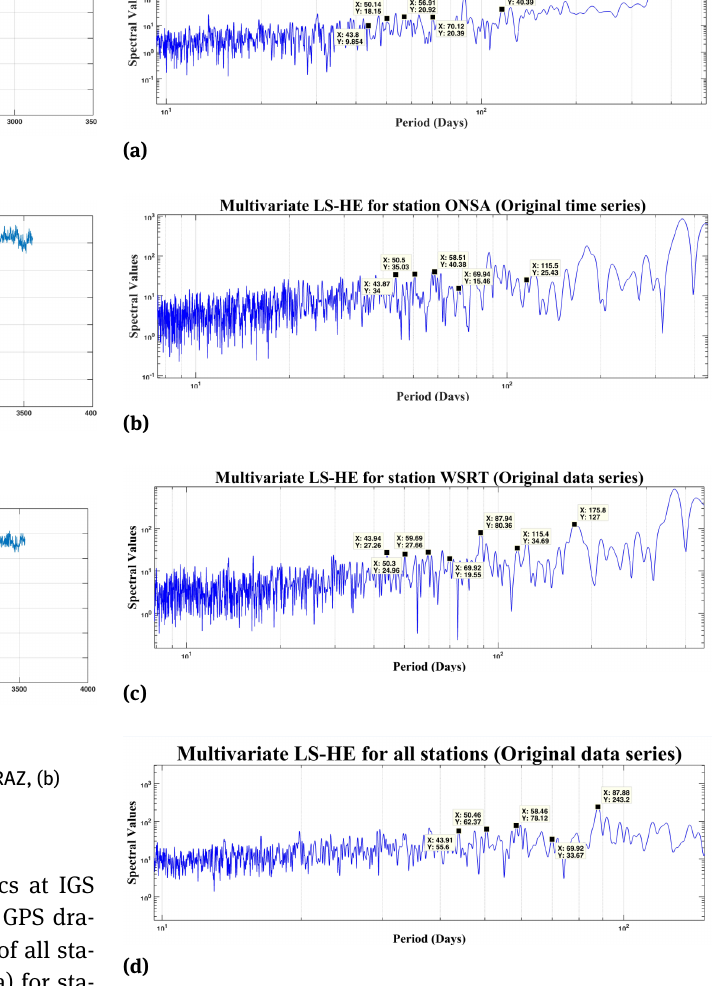
Figure 10: loglog plot for multivariate LSHA of original time series - X is period and Y is spectral value. Station: (a) GRAZ, (b) ONSA, (c) WSRT, (d)